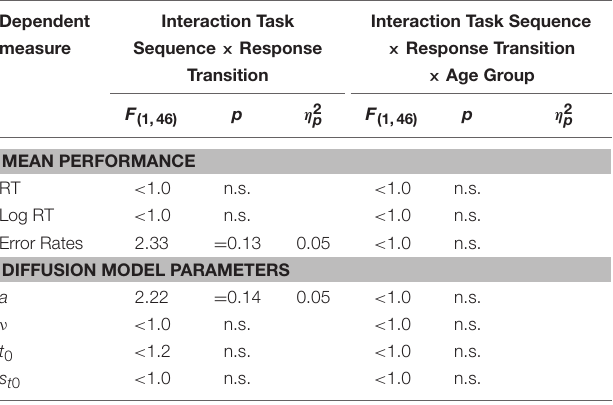
TABLE 3 | Analysis of Task Inhibition and Response Inhibition: Results of the 2 × 2 × 2 ANOVAs with within-subjects variables Task Sequence (ABA, CBA) and Response Transition (Response Repetition, Response Switch) and between-subjects variable Age Group (young adults, older